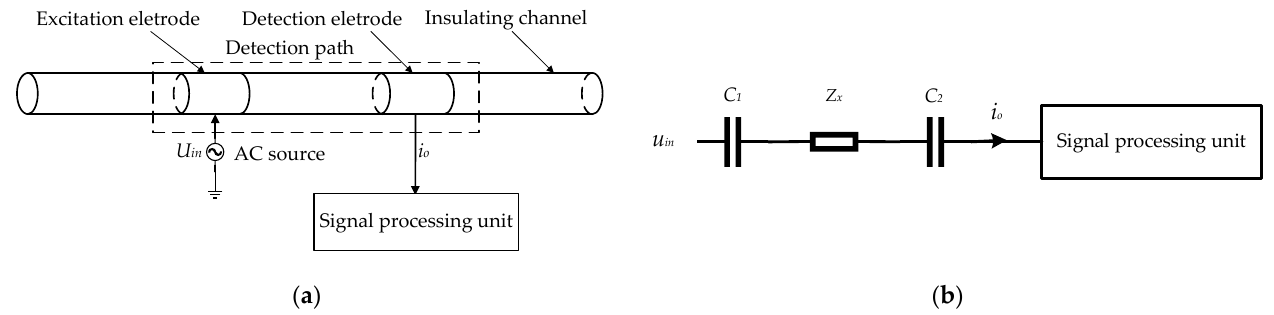
Figure 1. Measurement principle of CID: ( a ) construction of a typical CID sensor; ( b ) simplified circuit of the CID sensor.